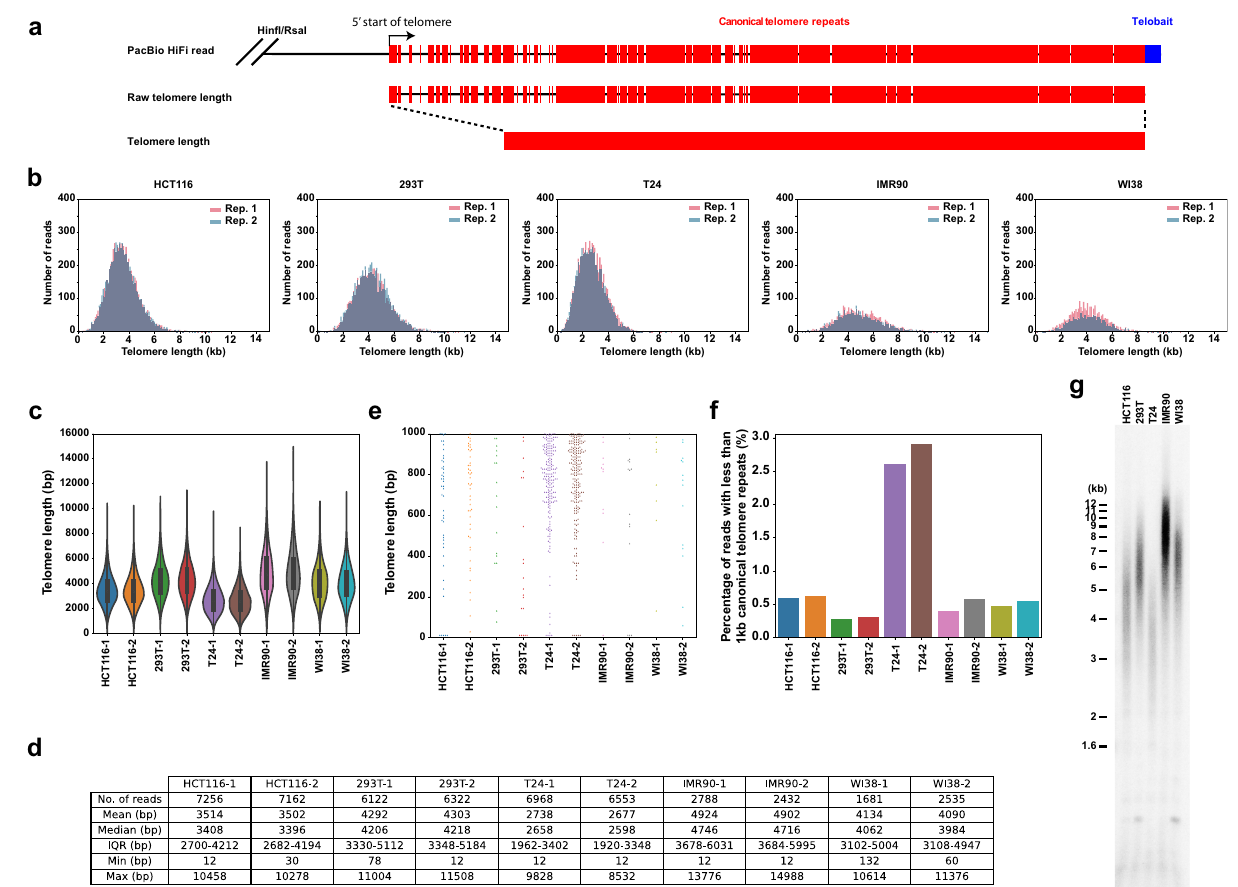
Fig. 2 | Telomere length measurement in culture cells using PacBio HiFi sequencing. a Schematic illustration for the estimation of raw telomere length or telomerelength withorwithout the inclusion ofheterogenous TVSs insequencing reads,respectively. b , c Histogramsandviolinplotsoftelomerelengthdistribution in HCT116, 293T, T24, IMR90 (PD47), and WI38 (PD40) cells obtained from two biological replicates (Rep.) in a single sequencing run. PD population doubling. Withineachviolin,thewhitecentercircledenotesthemedianvalue,theboundsof box represent the 25th to 75th percentile values, the whiskers represent adjacent values within 1.5 interquartile range, the ends of the whiskers depict the minimum and maximum values within the range, and the violin shape re fl ect the kernel density plot of the entire dataset. Source data are provided in Source Data 2. d .